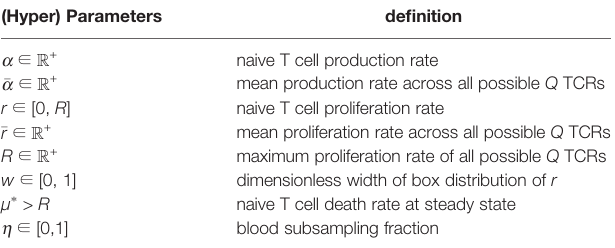
TABLE 1 | Model parameters q and hyperparameters q 0